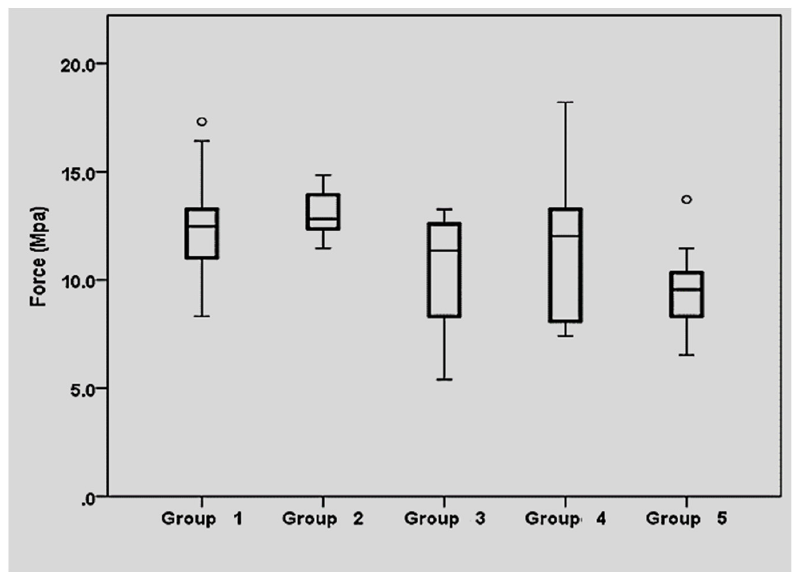
Figure 2. Mean shear bond strength of the different groups. Surface treatment: Group 1: Cleaning with HF after contamination; Group 2: cleaning with H 3 PO 4 after contamination; Group 3: Silanization before and after contamination; Group 4: Silanization only before contamination; Group 5: Sealing of the ceramic with adhesive. ◦ : Extreme outliers: the outliers are points that stay out of the interval. Table 2. Shear bond strength values. Groups with the same letter are not significantly different ( p > 0.05). N